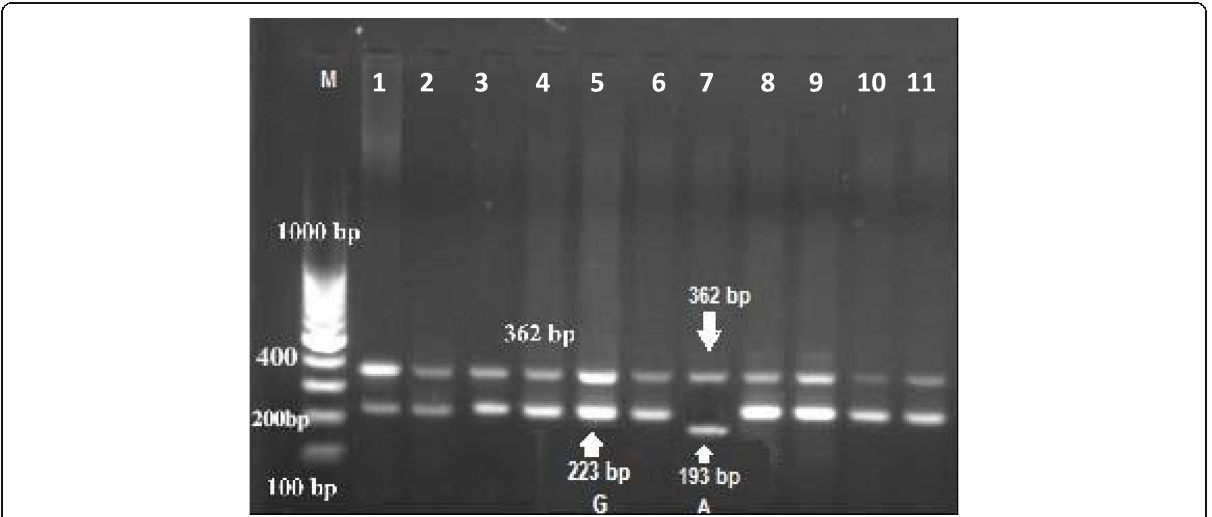
Fig. 3 Electrophoresis of agarose gel (2%) of polymerase chain reaction (PCR) product of tetra-primer amplification refractory mutation system- PCR for G6 locus of GDF9 gene. The Lanes of 1 to 11: Amplification of wild type or heterozygous in a mother sheep genomic DNA. Sizes of the common outer product (362 bp) and allele-specific wild type (223 bp) and mutant-type (193 bp) inner product are indicated by an arrow of the respective gel photograph. Lane M: DNA molecular weight marker (O` Range Ruler 100 bp DNA Ladder, Fermentas, Lithuania). G = wild type allele, A = mutant allele